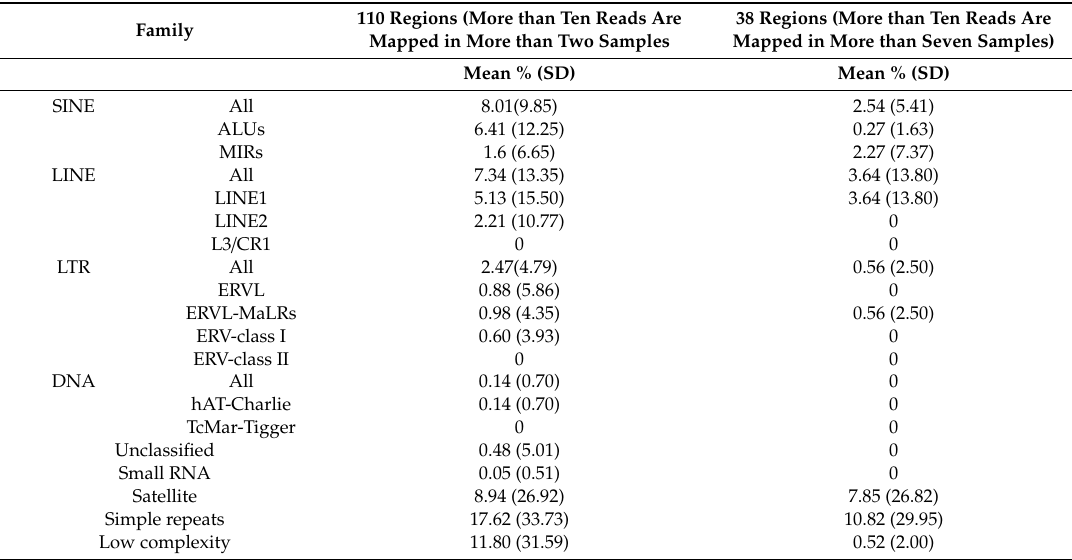
Table 3. The distribution of repetitive sequences on the putative missing regions on AK1 sca ff olds. The estimated missing regions by unmapped reads, 110 regions ( ≥ X10, ≥ 2 indiv) and 38 regions ( ≥ X10, ≥ 7 indiv), were investigated on the distribution of repetitive sequences with Repeat Masker. Mean% (SD). 110 Regions (More than Ten Reads Are 38 Regions (More than Ten Reads Are Family Mapped in More than Two Samples Mapped in More than Seven Samples) Mean % (SD) Mean % (SD) SINE All